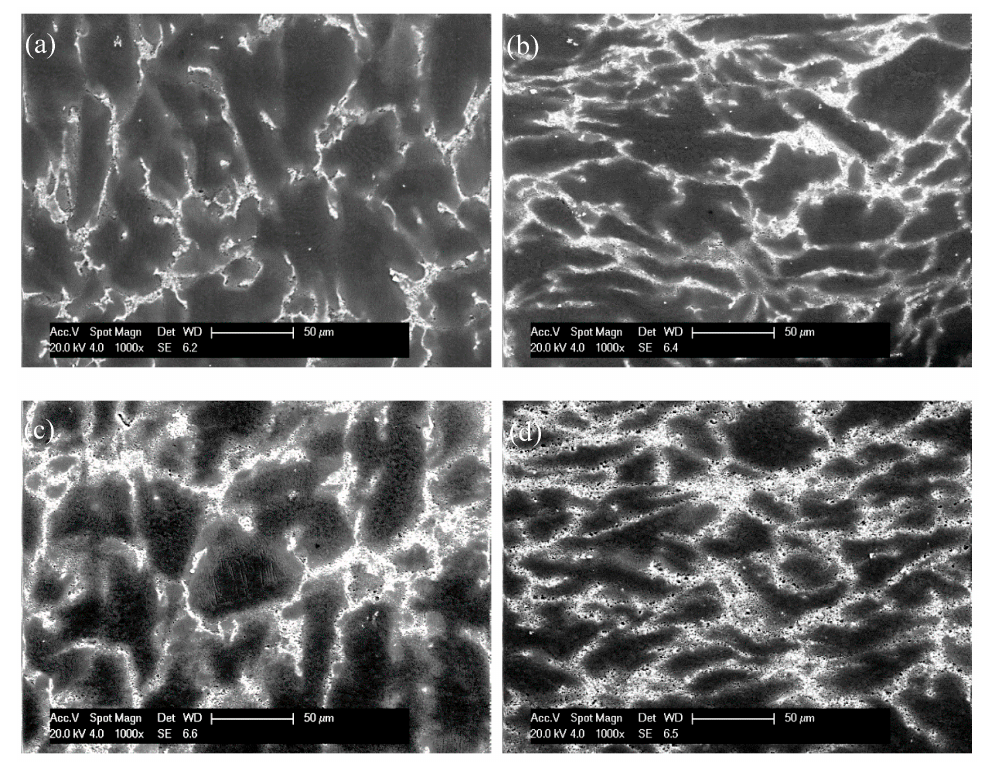
Figure 6. SEM images of ECAP alloys: ( a ) 1p; ( b ) 4p; ( c ) 8p; ( d ) 16p.